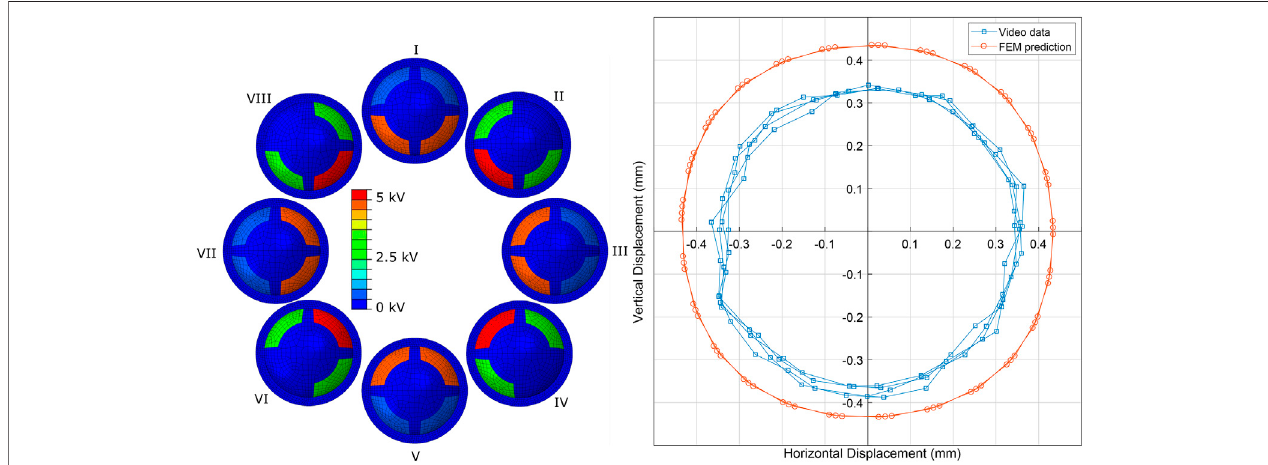
FIGURE 11 | FEM Comparison. Left: MIDA FEM model showing the voltages applied to the segments during a ‘ circular ’ actuation, I - VII show the progression of the cycle. Right: A comparison of simulated (circular markers) versus experimental data (square markers) during actuation at 5 kV, with 90 ° phase staggering between adjacent electrodes. Data is shown for 3